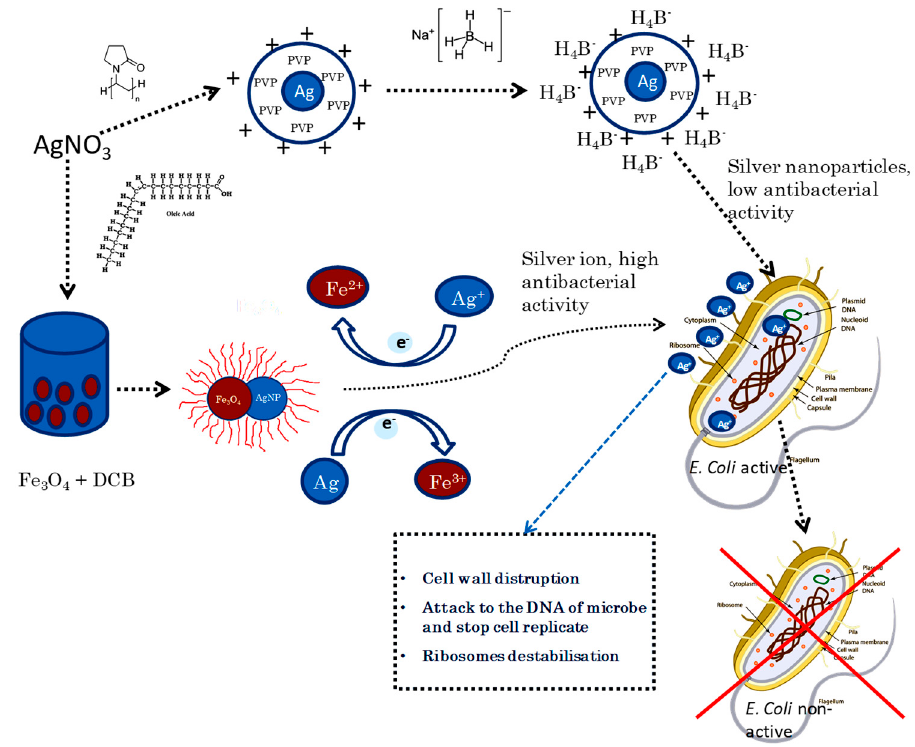
Figure 4. Mechanism of inactivation of E. coli by FeAg NPs in which the electron exchange between Ag NPs and Fe NPs promotes the formation of the Ag+-ion leading to inactivation of E. coli .